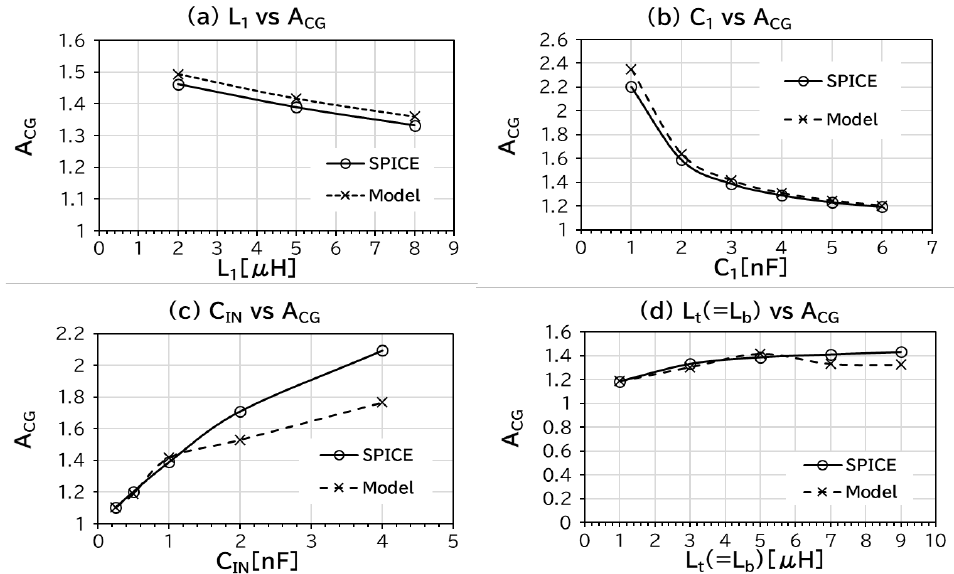
Figure 9. A CG as a function of each design parameter. ( a ) L 1 vs. A CG , ( b ) C 1 vs. A CG , ( c ) C IN vs. A CG , ( d ) L t (=L b ) vs. A CG .